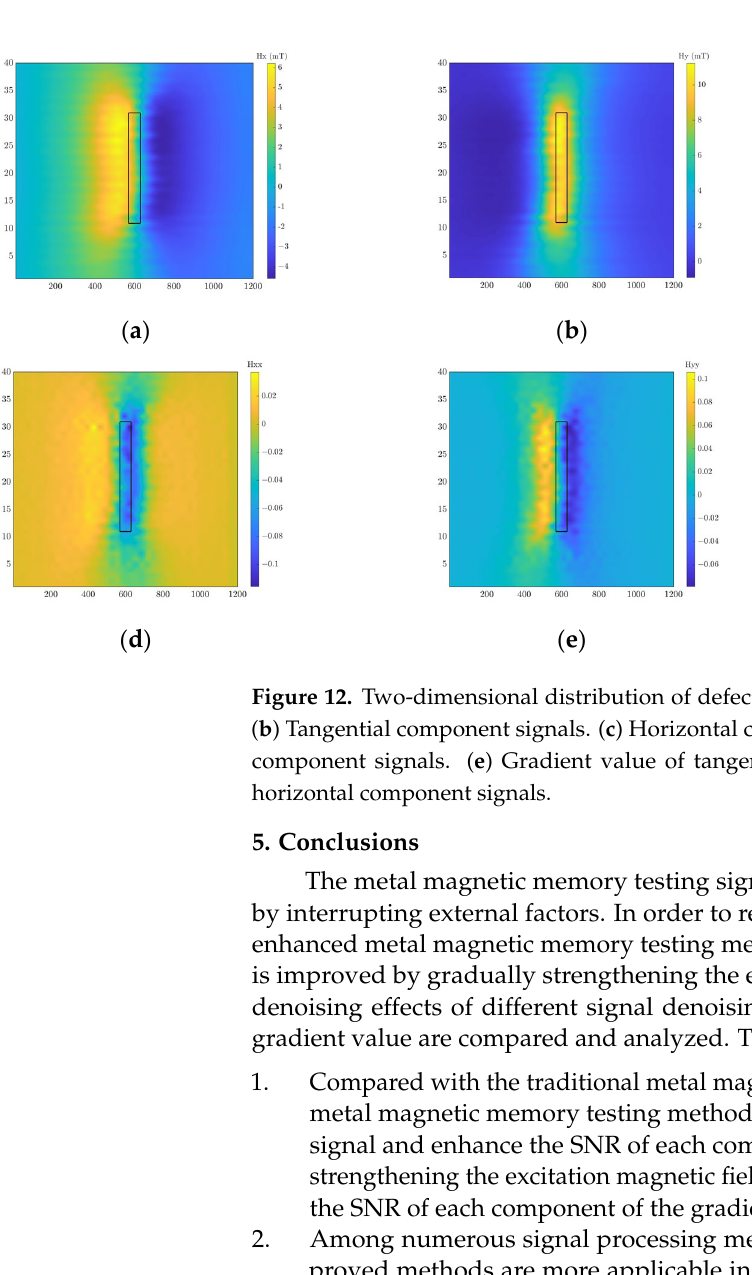
values of tangential component signal. ( f ) Comparison of gradient values of horizontal component signal.